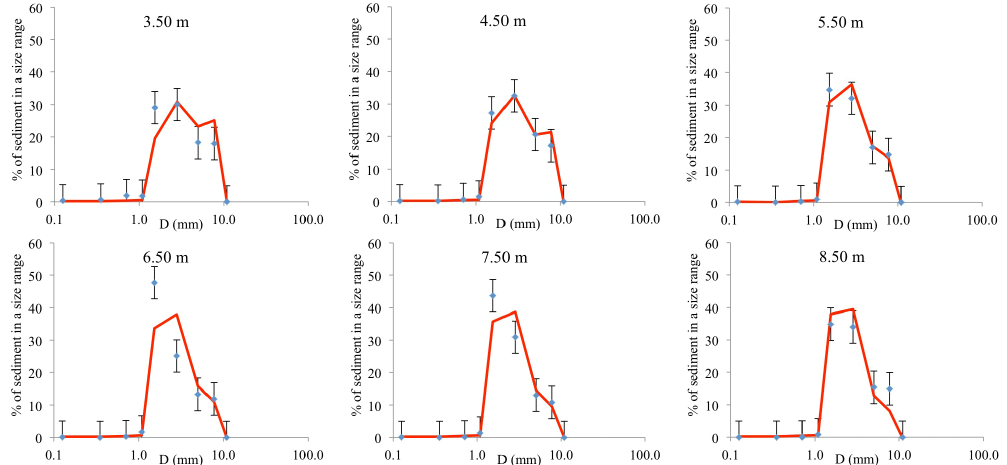
Figure 7. Comparison between predicted and measured grain size distributions of the topmost part of the delta top. The diamonds represent the measurements and the red line is the numerical result. Error bars denote a ± 5% error.